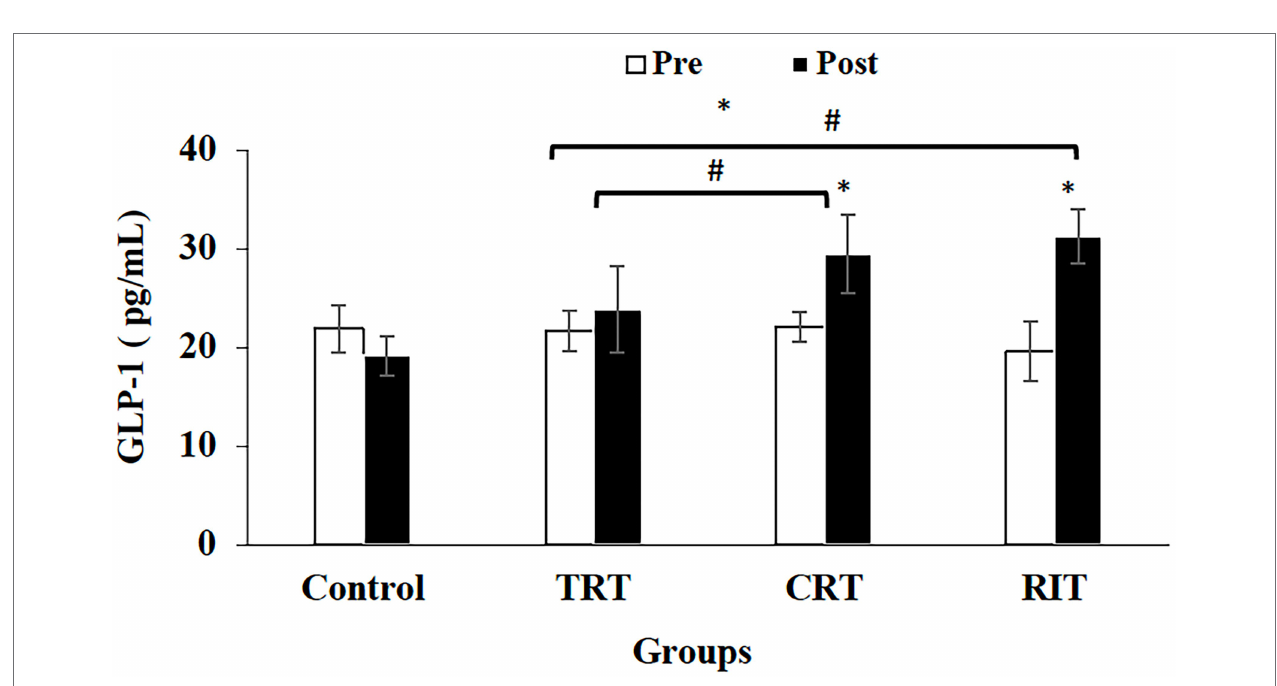
FIGURE 4 | Pre- and post-training values (mean ± SD) for Glucagon-like peptide-1 in TRT, CRT, and IRT groups. * Indicates significant differences from the control group ( p < 0.05). # Indicated significant differences between training protocols ( p <